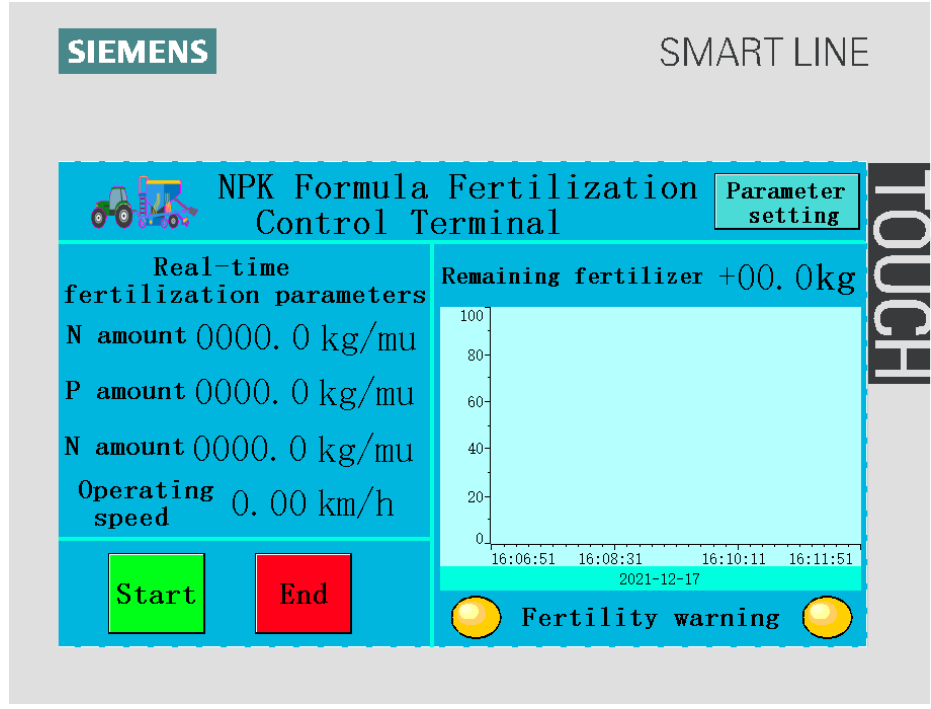
Figure 6. Software operation interface.